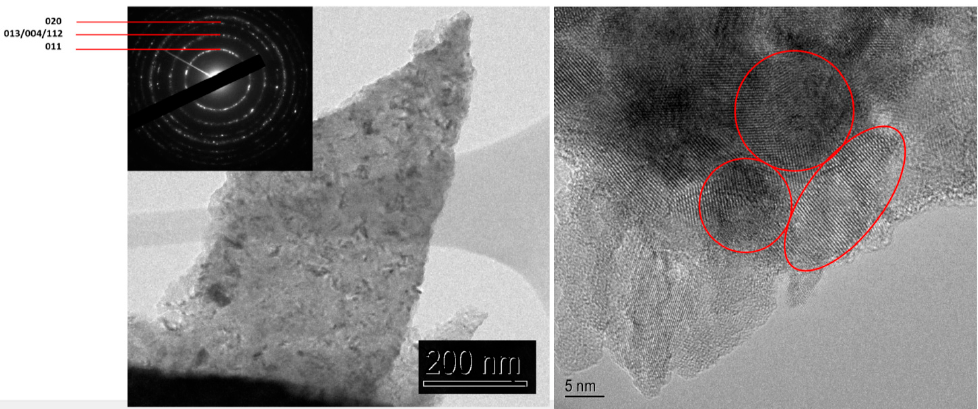
Figure 6. Bright field image from TiO 2 / Al–Zr film and the corresponding selected area electron diffraction pattern indicate the formation of the nanocrystalline anatase TiO 2 phase.